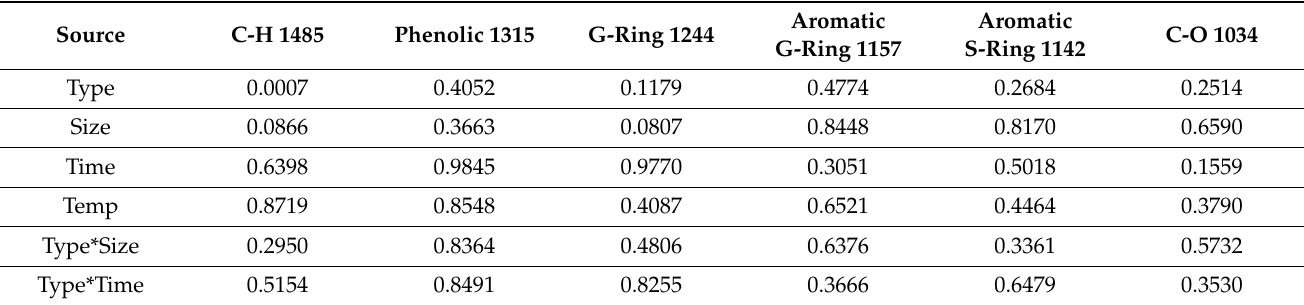
Figure 3. FTIR spectra for stem particles at varying sizes, times and temperatures; ( a ) 250 µ m for 5 h, ( b ) 250 µ m for 15 h, ( c ) 250 µ m for 25 h, ( d ) ball-milled for 5 € , ( e ) ball-milled for 15 h and ( f ) ball-milled for 25 h. Table 7. Summary of F-value significance based on ANOVA for physical and thermal pretreatment at 1485, 1316, 1244, 1159, 1142 and 1035 cm − 1